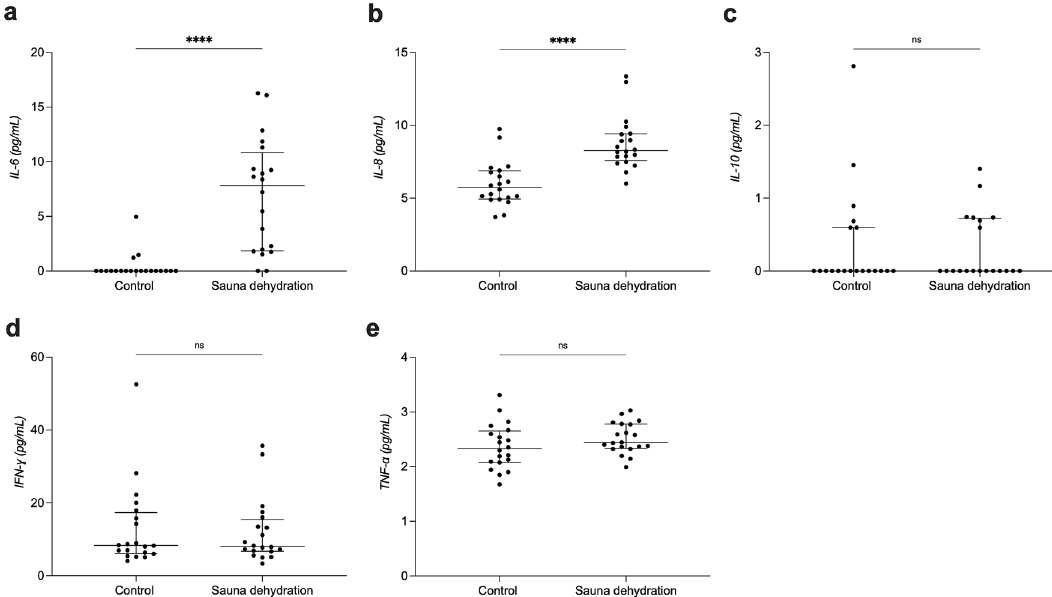
Figure 4. Plasma cytokine concentrations at the control condition and after sauna dehydration. ( a ) IL-6. ( b ) IL-8. ( c ) IL-10. ( d ) IFN- ɣ . ( e ) TNF-α. The horizontal line marks the median, the vertical line spans through the interquartile range (IQR). The dots represent the individuals. *** P < 0.001. **** P < 0.0001. ns, non-significant.